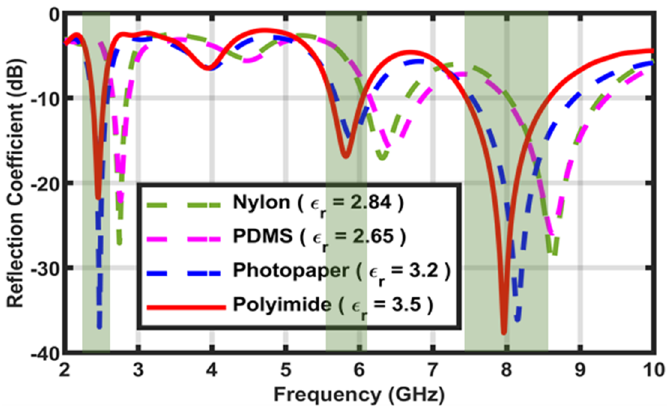
Figure 15. Compression analysis of the antenna by varying the thickness and permiivity.